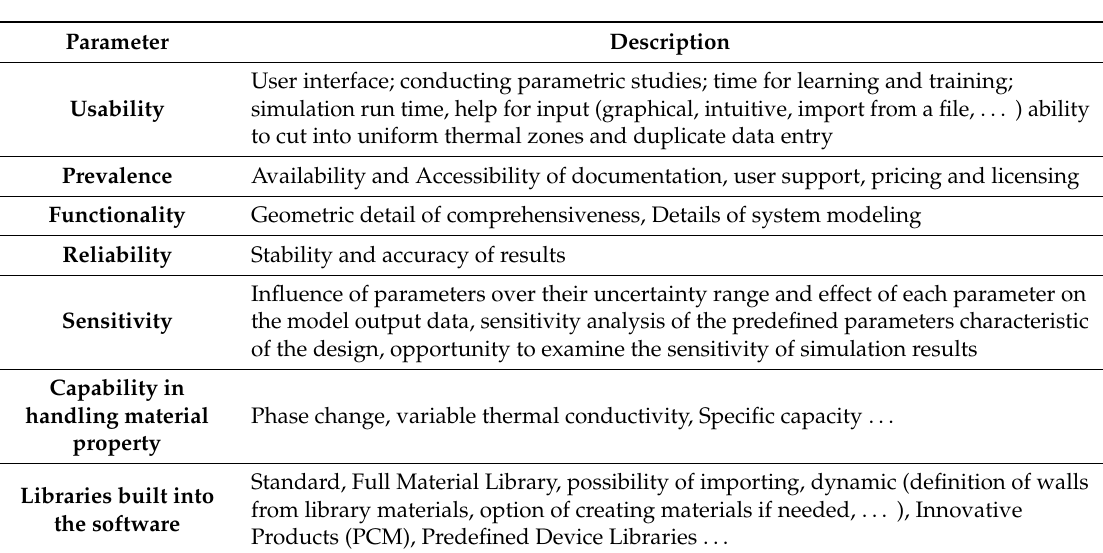
Table 2. Comparison parameters of simulation